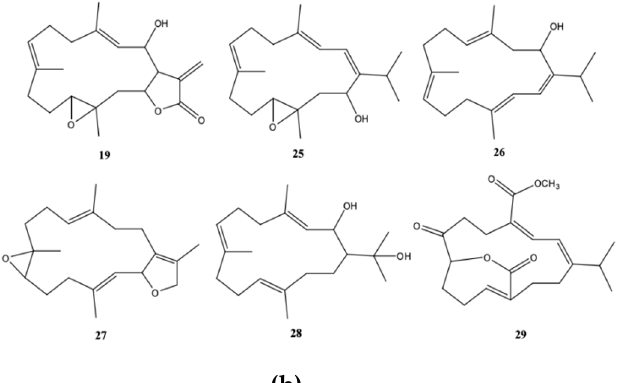
Figure 3. Cembranoid diterpenes isolated from Sarcophyton sp. on the reef at Mahengetang Island (Indonesia) [31]. a ) The